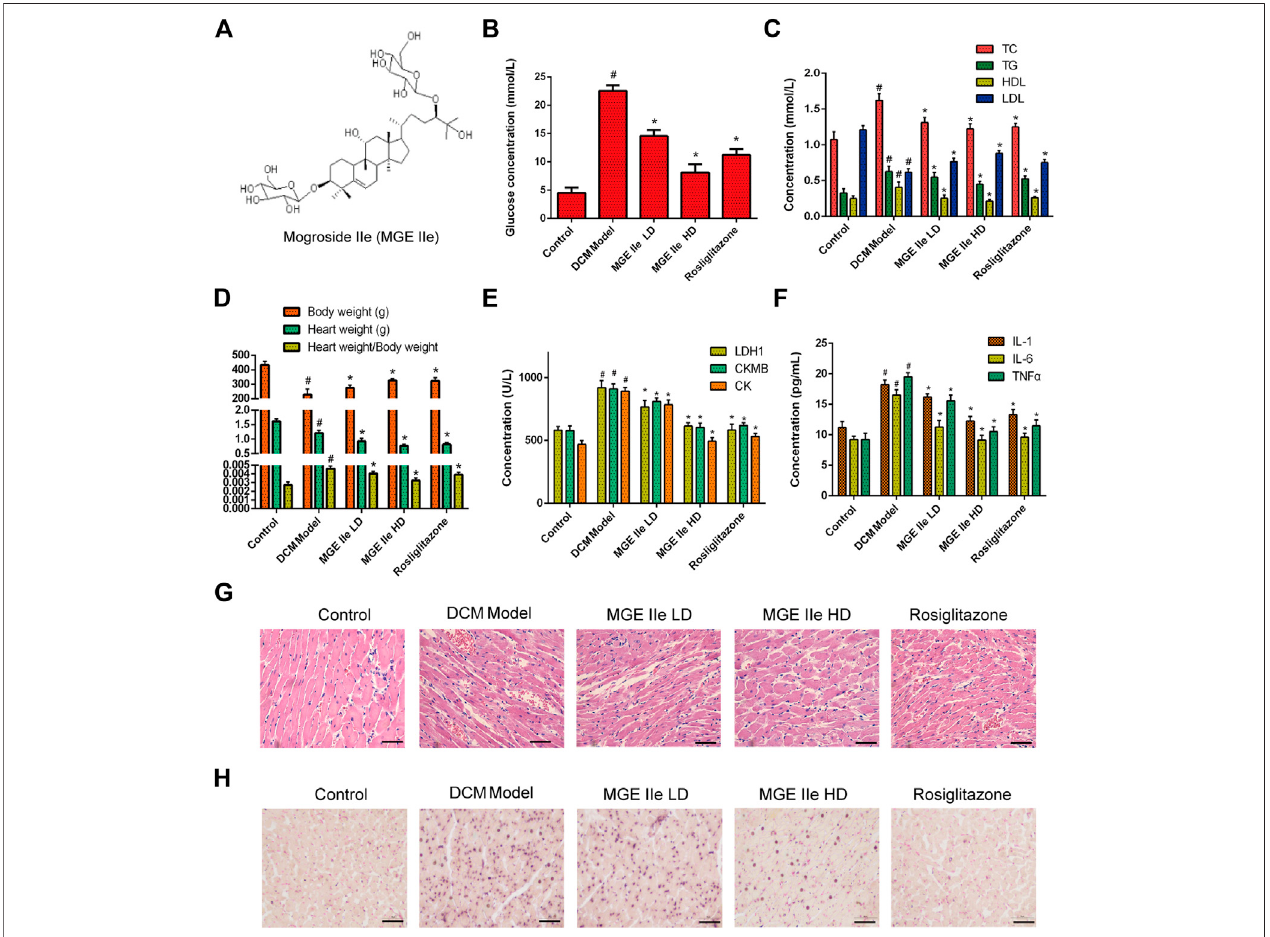
FIGURE1| MGEIIeslowsdownthedamagetocardiomyocytesintheDCMmodel. (A) ThestructuralformulaofMGEIIe. (B) MGEIIedecreasedtheserumglucose concentration. (C) MGE IIe inhibited lipid accumulation. (D) MGE IIe decreased the ratio of heart to body weight. (E) MGE IIe improved cardiac function. (F) MGE IIe inhibited the secretion of in fl ammatory cytokines. (G) MGE IIe improved cardiomyocyte damage as revealed by HE staining. (H) MGE IIe reduced cardiomyocyte apoptosisasrevealedbyTUNELstainingassay.Bar (cid:2) 50 µm.One-wayANOVAwasfollowedbyposthoctestsforcomparisonsamonggroups.Thevaluesshown represent the mean ± standard error of the mean (SEM) of the data from three independent experiments. # p < 0.05 (compared to the control group alone); * p < 0.05 (compared to the model group alone).